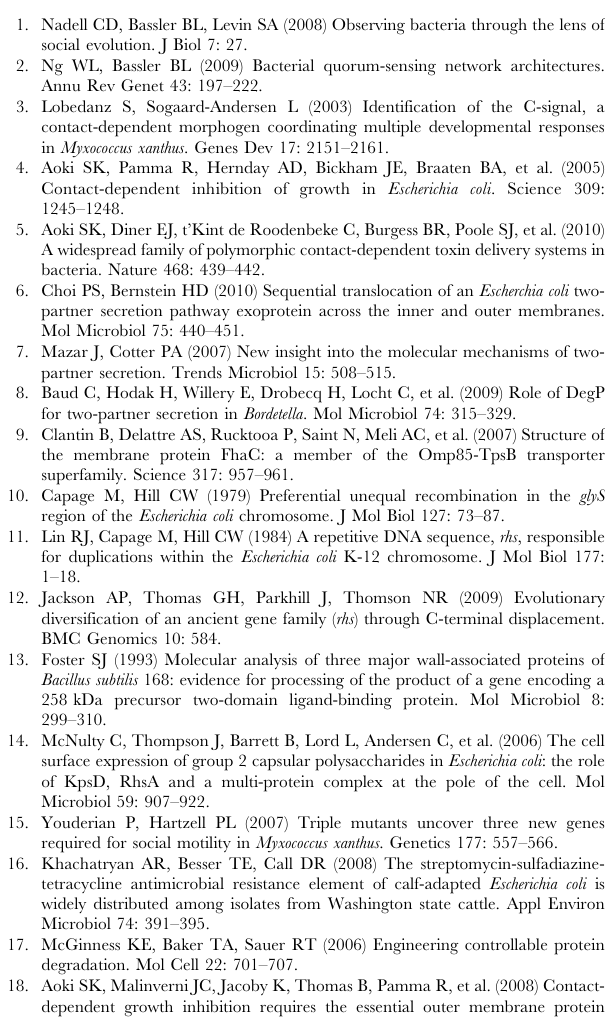
Figure S6 Orphan cdiA-CT/cdiI modules from D. dadantii 3937 and E. coli EC869 encode functional toxin/immunity pairs. A) Purification of orphan CdiA-CT/CdiI-His 6 proteins. CdiA- CT o13937 /CdiI o13937 -His 6 and CdiA-CT o11EC869 /CdiI o11EC869 - His 6 complexes were purified by Ni 2 + -affinity chromatography under non-denaturing conditions and analyzed by SDS-PAGE. B) Growth curves of E. coli D sspB cells expressing orphan CdiA-CT/ CdiI-DAS complexes. Degradation of CdiI-DAS proteins was initiated by the addition of L-arabinose to induce SspB synthesis. Control cells express SspB( D 47), which does not deliver CdiI-DAS proteins to the ClpXP protease. Growth curves with square symbols represent control strains expressing SspB or SspB( D 47), but not orphan CdiA-CT/CdiI-DAS complexes. (TIF) Figure S7 The CdiA I -CT of Y. pestis Microtus 91001 is related to an Rhs-CT from Waddlia chondrophila . Pairwise alignment of Y. pestis Microtus CdiA-CT 91001(I) (Q74T84) and the C-terminal region of a predicted Rhs/YD-repeat protein from Waddlia chondrophila WSU 86–1044 (D6YTT8). Regions of sequence identity are shaded gray and the PxxxxDPxGL and VENN peptide motifs are boxed. (TIF)